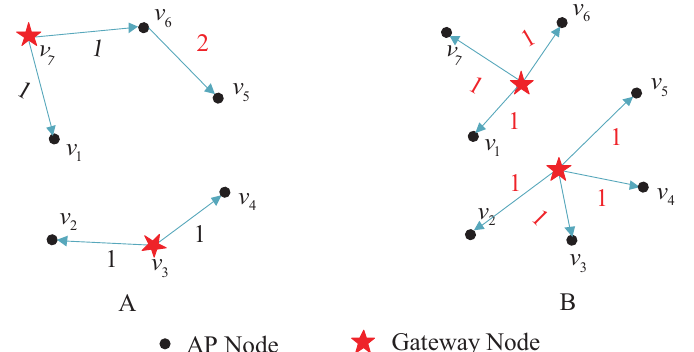
Figure 3. Deployment diagram of two gateways. ( A ) gateways deploying on nodes; ( B ) gateways deploying not on